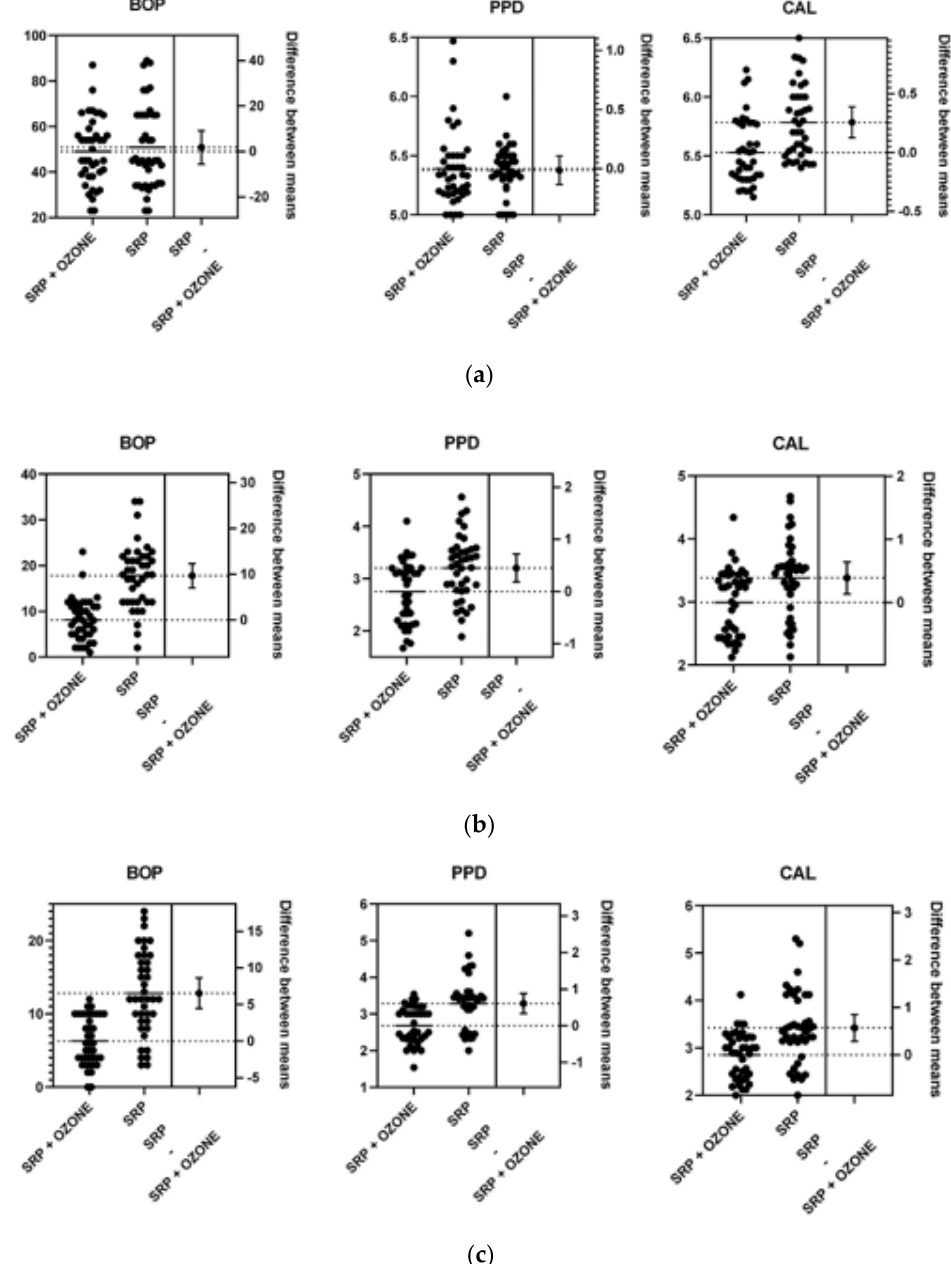
Figure 2. The difference between means at baseline ( a ), 3 ( b ) and 6 ( c ) months.